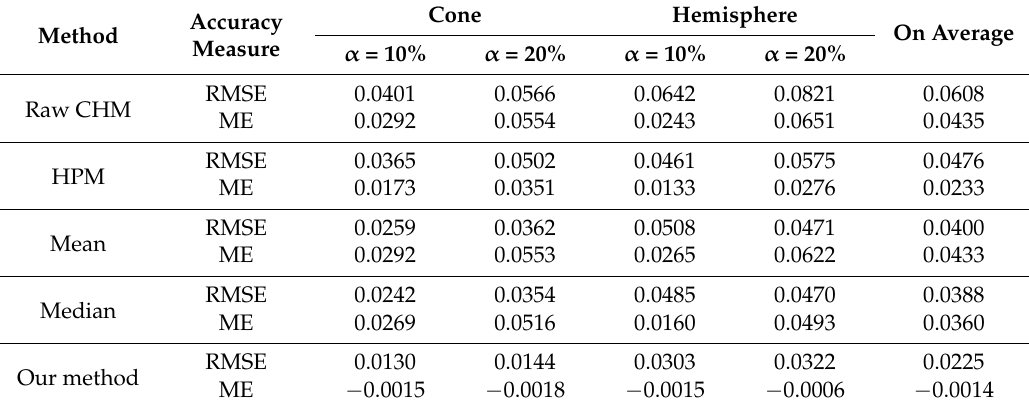
Table 1. Accuracy comparison between our method, raw CHM, and three other methods for removing data pits under different contaminating proportions ( α ) in the numerical